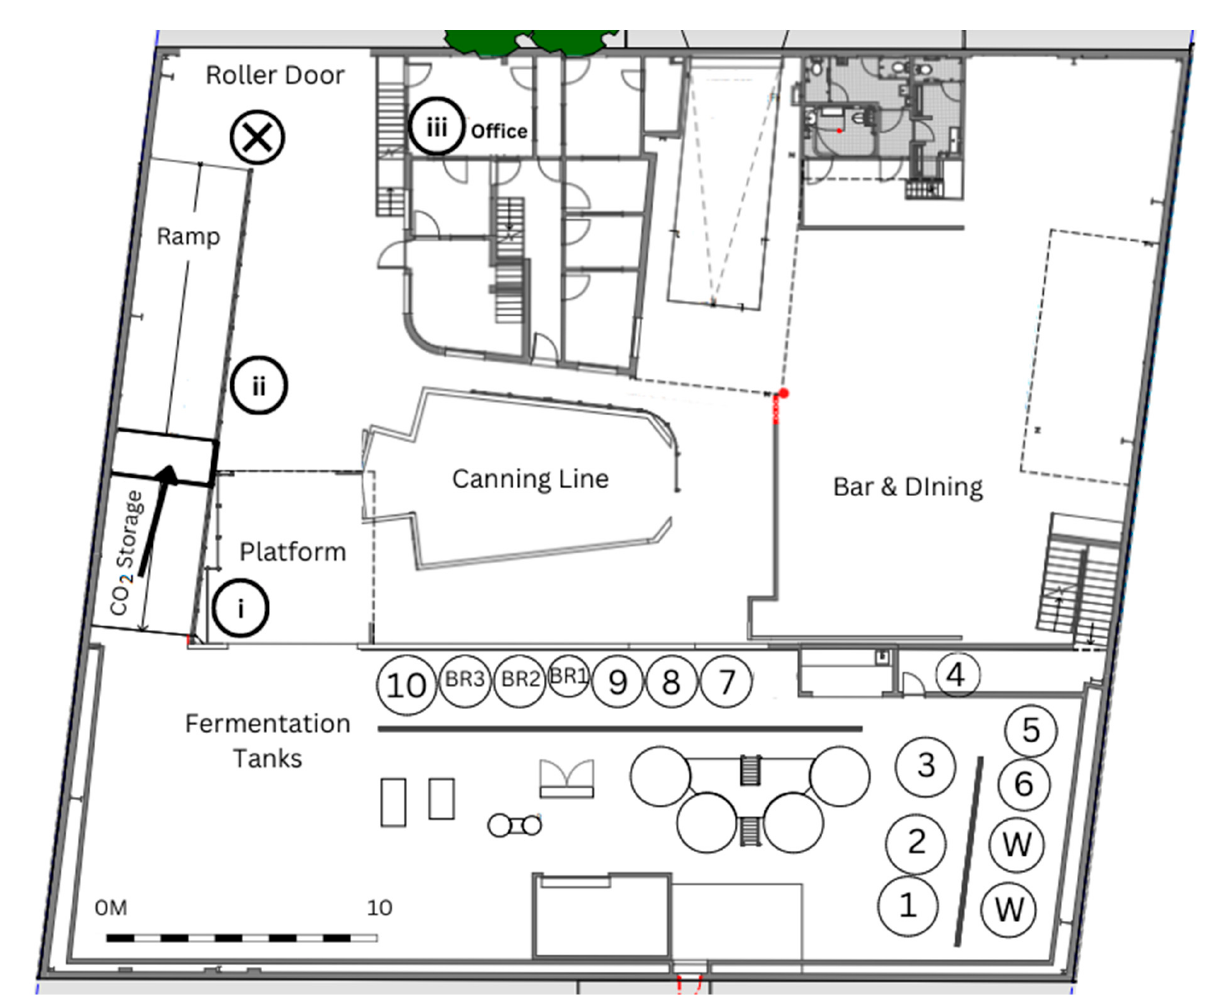
Figure 2. A floorplan of the brewery. Sensor positions, X: hardwired. i: Node 1, ii: Node 2, iii: Node 3, W: water tanks, BR1–3: bright beer tank, numbers 1–10 indicate the fermentation tank numbers, the arrow indicates the CO 2 storage.